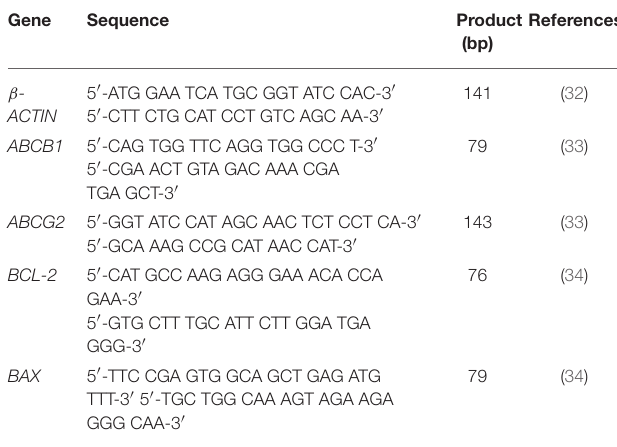
TABLE 1 | Primers used for real time PCR